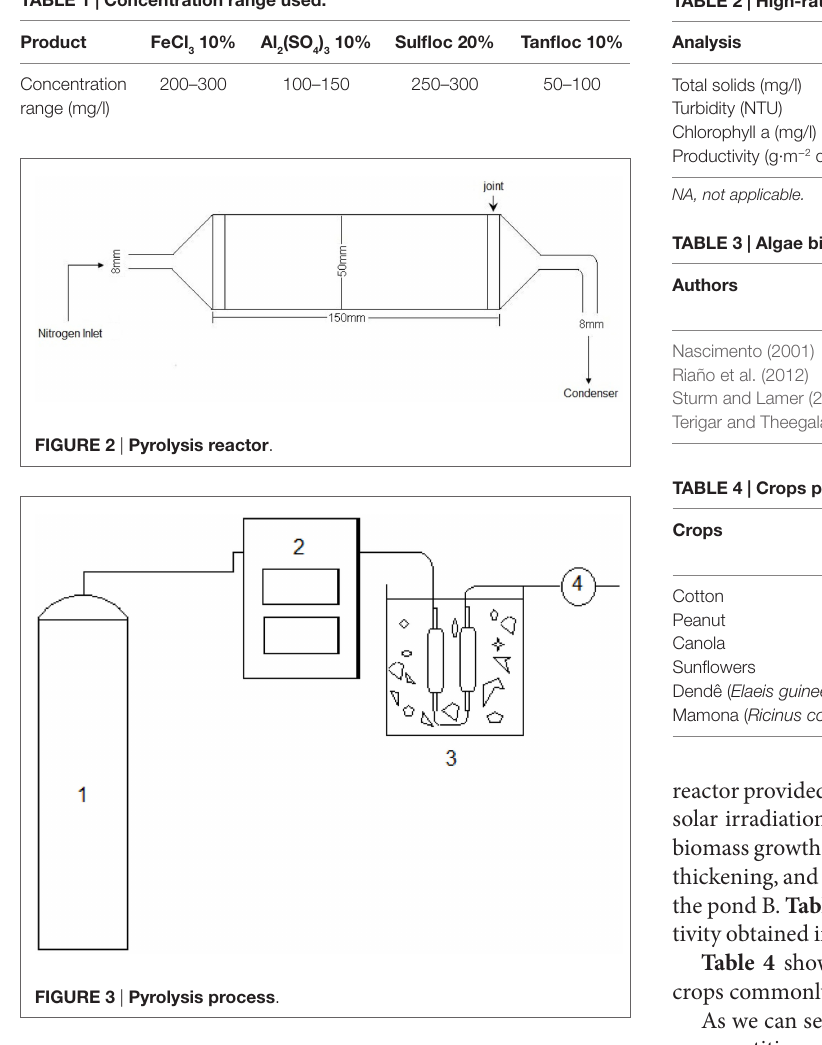
TaBle 1 | concentration range used.